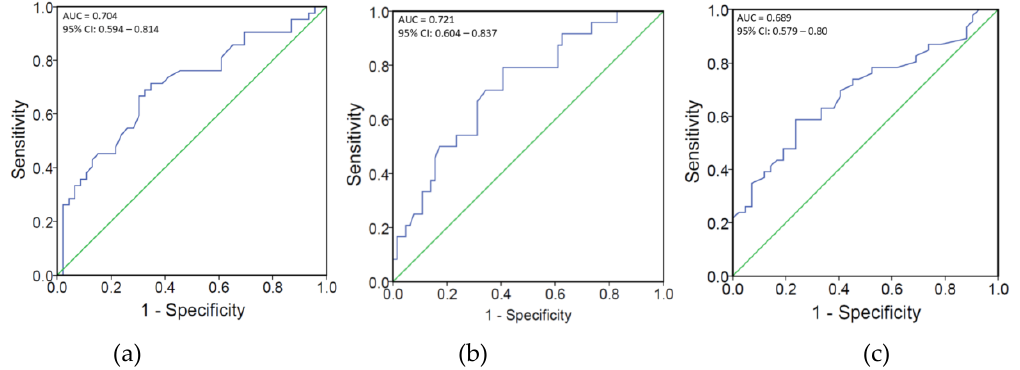
Figure 2. (a) area under the receiver operating characteristic curve for 25(OH)D concentration in spontaneous pain; ( b )the area under the receiver operating characteristic curve for 25(OH)D status spontaneous pain; (b) the area under the receiver operating characteristic curve for 25(OH)D status in in brush-evoked pain; ( c )the area under the receiver operating characteristic curve for IgM titer in brush-evoked pain; (c) the area under the receiver operating characteristic curve for IgM titer in spontaneous spontaneous pain.